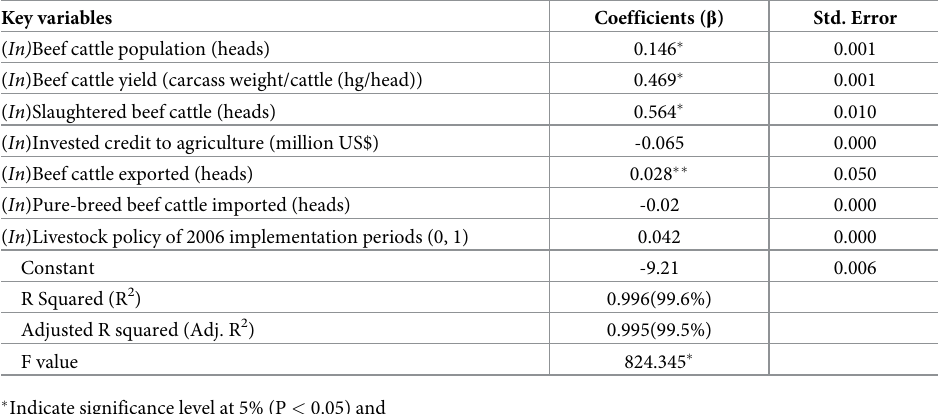
Table 4. Estimates of log-log linear Ordinary Least Squares (OLS) parameters on the factors that influenced beef meat production in Tanzania from 1990 to 2019. Key variables Coefficients ( β